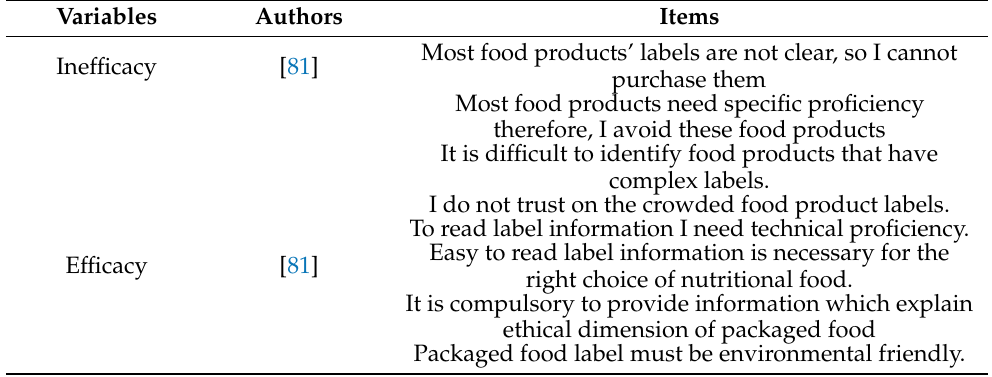
Table 1. Measurement